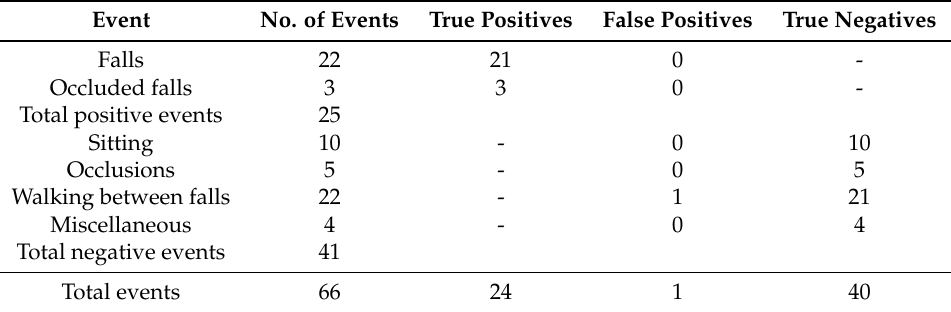
Table 1. Fall detection results.